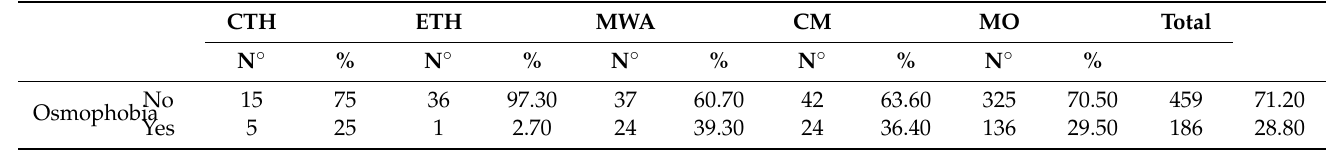
Table 1. Prevalence of osmophobia in the cohort of primary headaches. ETH: episodic tension-type headache; CTH: chronic tension-type headache; MWA: migraine with aura; MO: migraine without aura; CM: chronic migraine. Patients with ETH presented with a lower prevalence of osmophobia (chi-squared p <